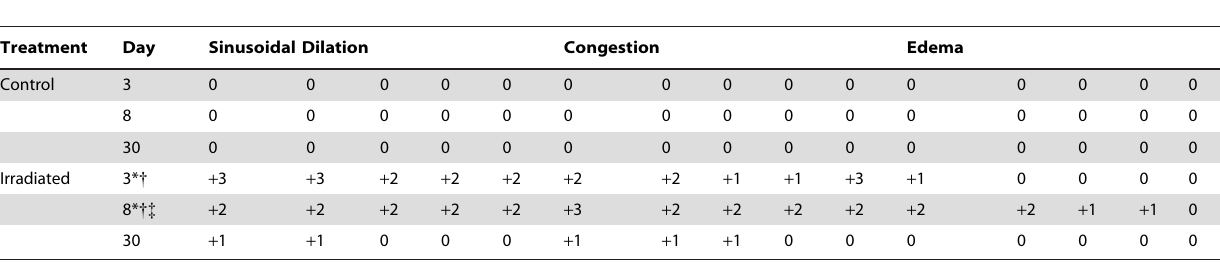
Table 2. Semi-quantitative assessment of vascular abnormalities in intact control (I 2 R) and irradiated (I + R) mice estimated by a board certified veterinary clinical pathologist (LS) according to standard